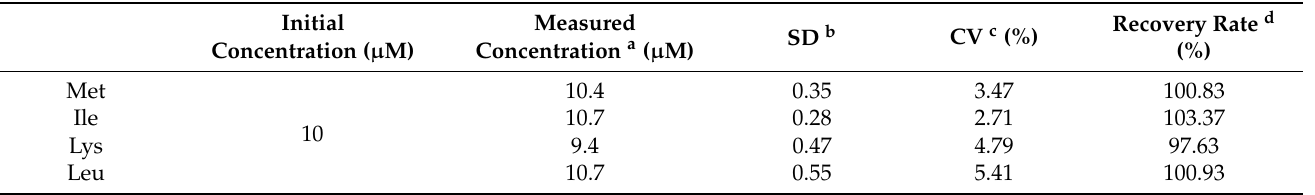
Table 1. Performance of the ready-to-use Met, Ile, Lys, and Leu arrays to determine Met, Ile, Lys, and Leu concentrations, respectively, after storage for 3 months.